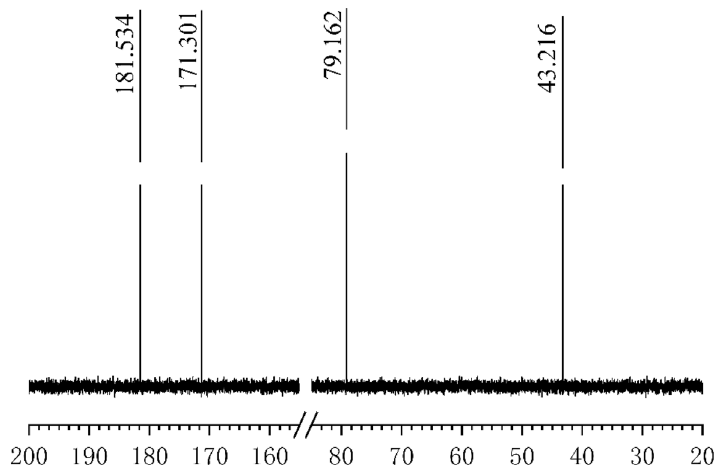
Figure 7. 13 C NMR spectrum of GlyGl after 3 h of electrolysis.